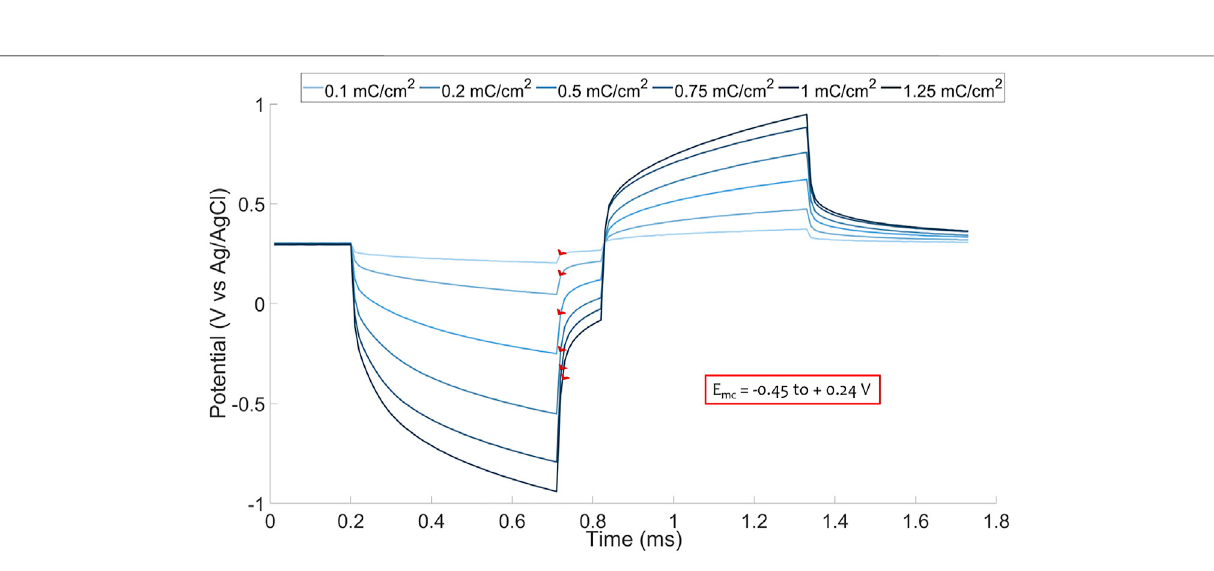
Frontiers in Nanotechnology |